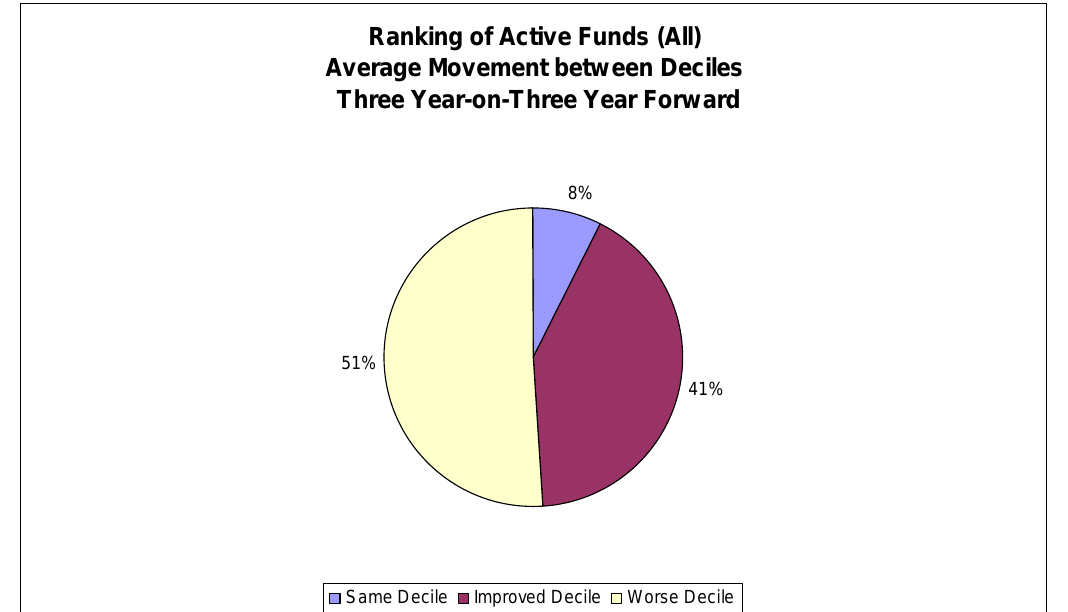
Figure 7: Tendency of actively managed funds to move between deciles on a three-yearly